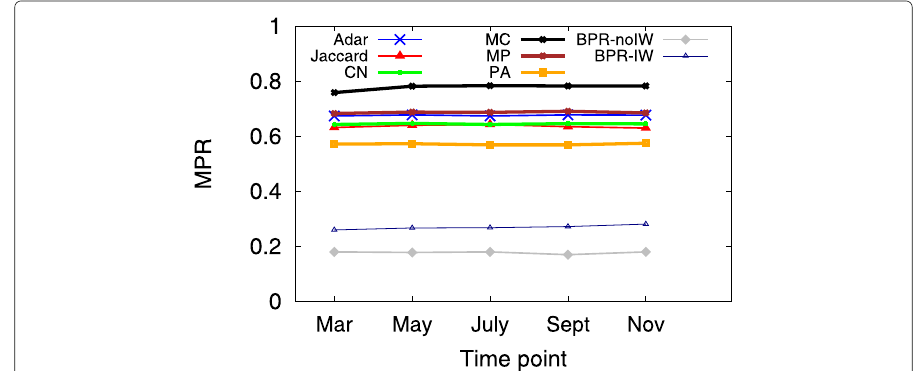
Fig. 4 MPR at several time points in 2011, when K = 20